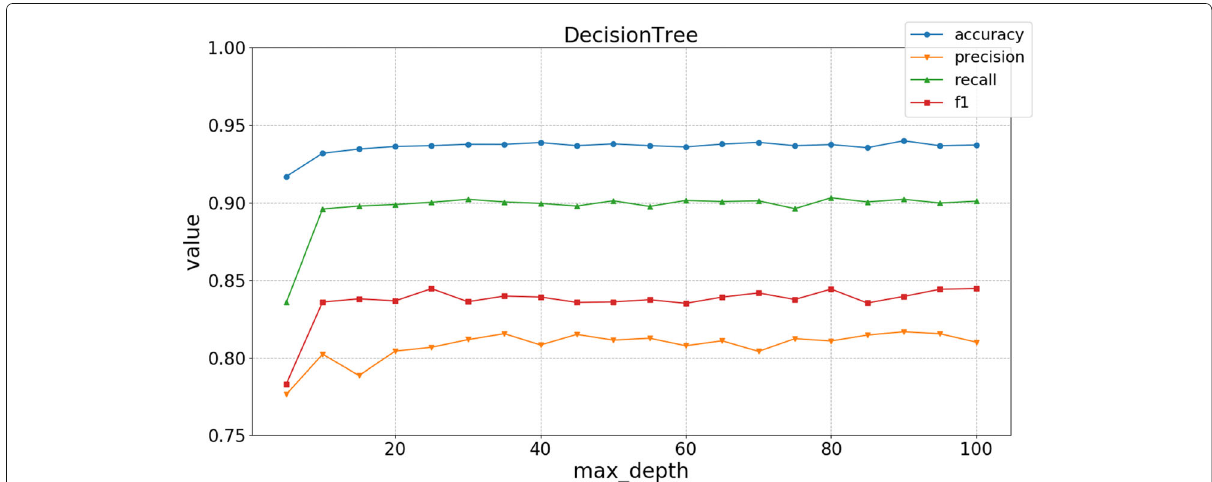
Fig. 4 Result of Decision Tree with regard to depth of tree. According to the experiment results, the four metrics remain constant when max _ depth is above 20, and their values may fluctuate a little. The accuracy is about 93%, while the precision is the lowest, which is around 80%. When max _ depth is about 25, the four metrics achieve the